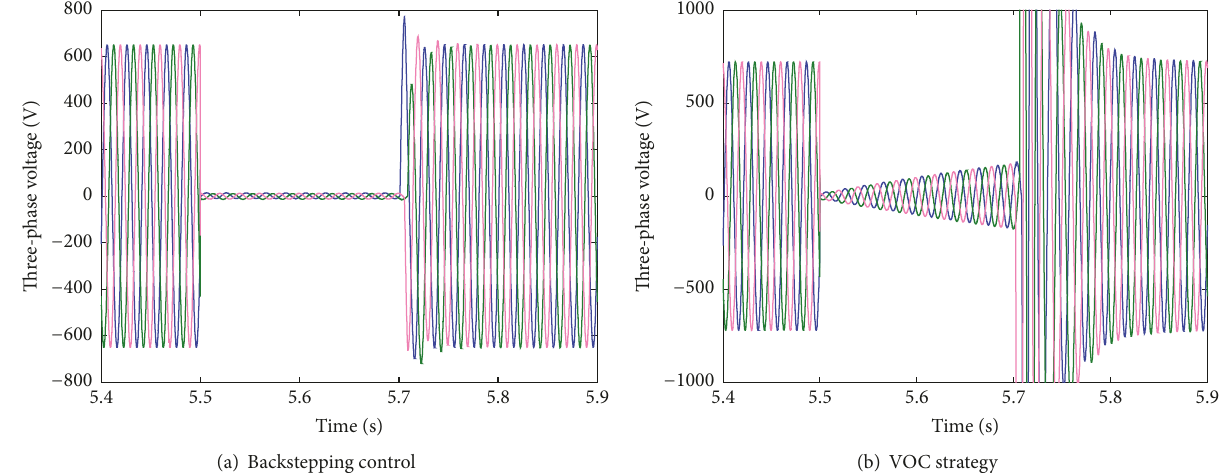
Figure 17: Zoom-in view of three-phase voltage at Bus